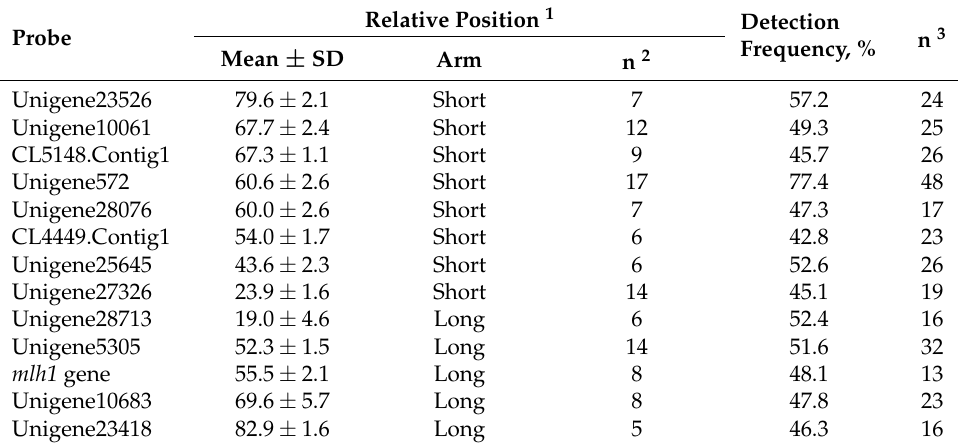
Table 2. Relative positions and detection frequencies of Tyr-FISH signals from molecular markers on mitotic metaphase chromosome 2 of